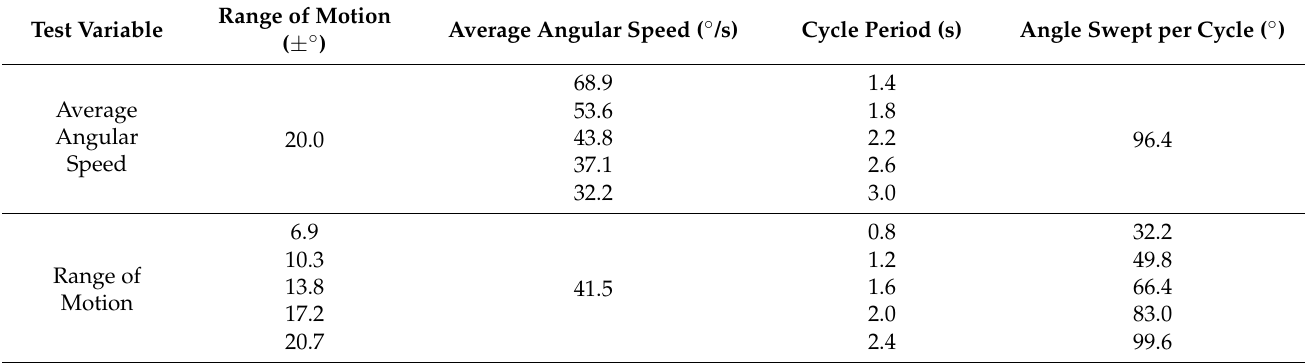
Table 3. In Vitro Test